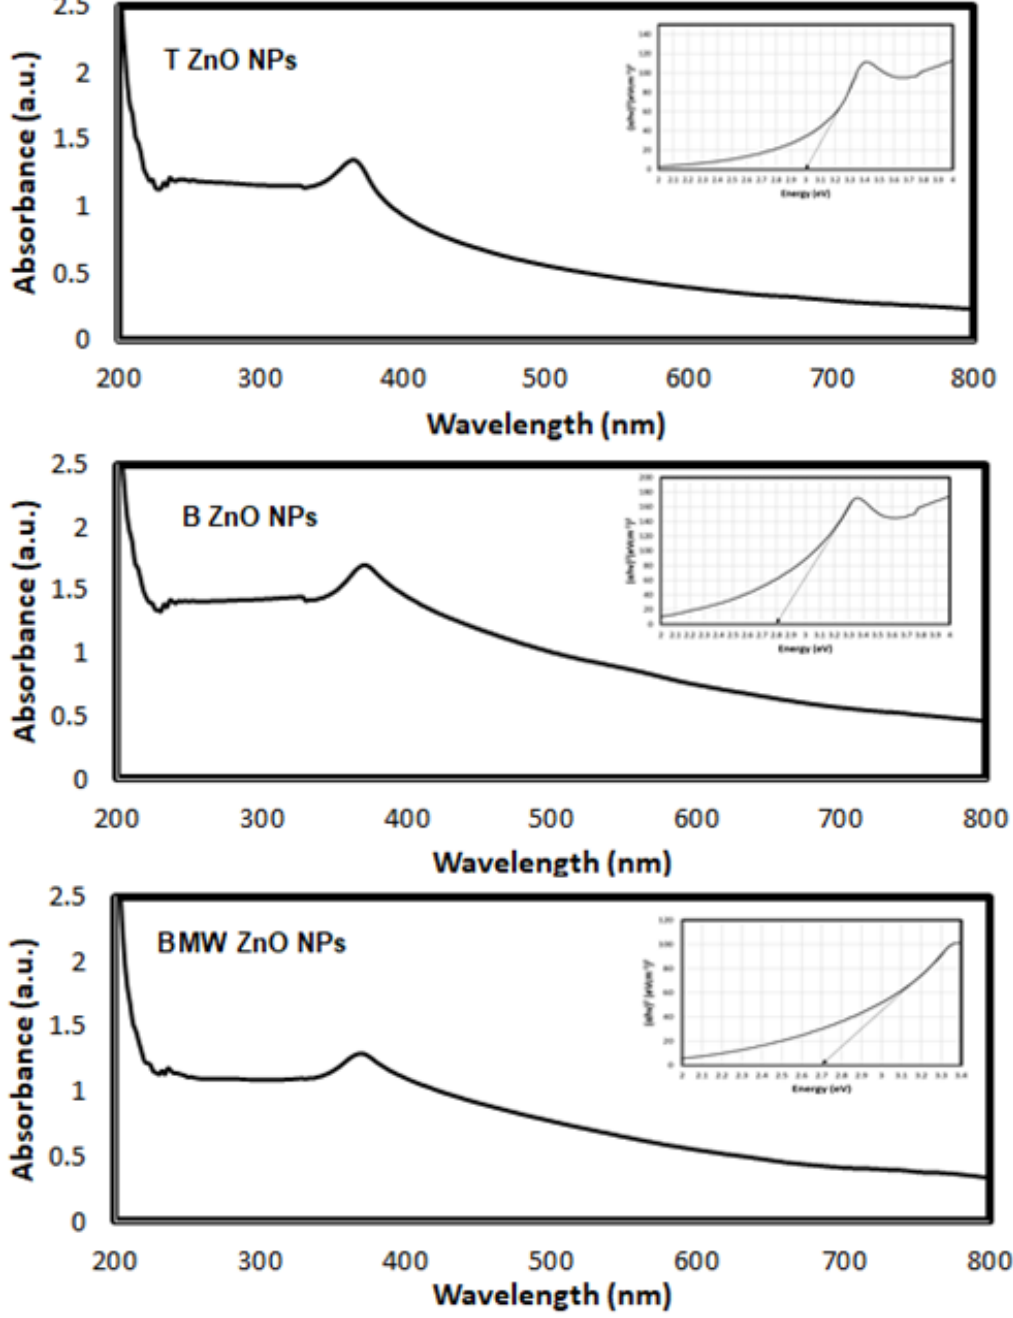
Figure 6. Evaluation of band-gap energy for ZnO photocatalysts.